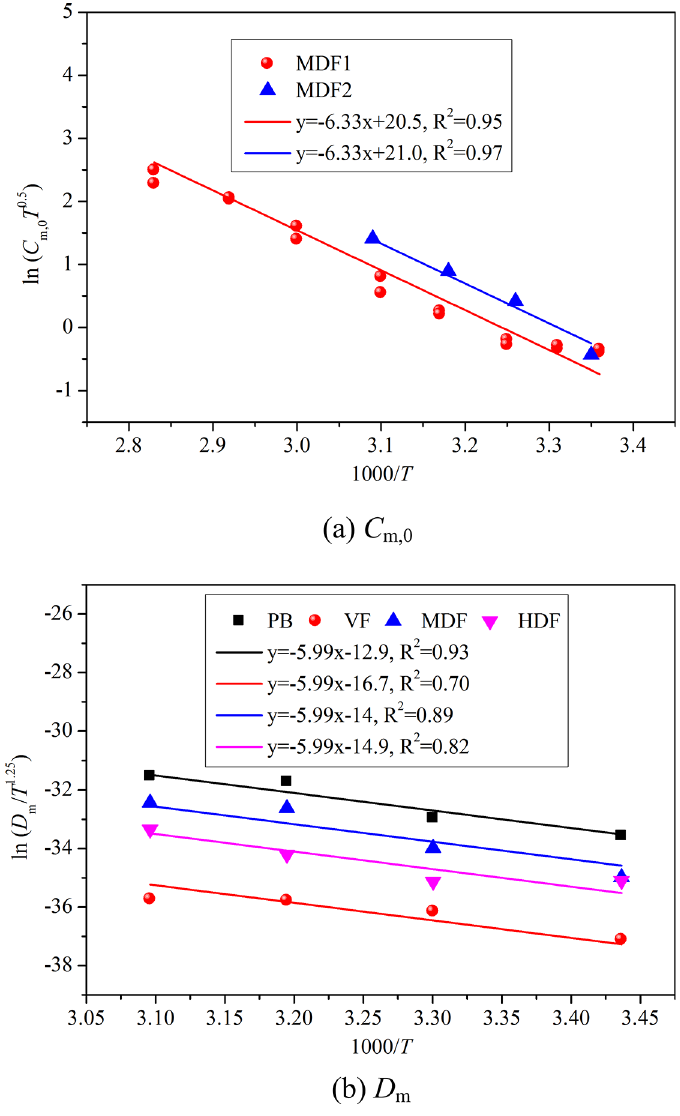
Fig 1. Linear curve fitting results by treating the experimental data with theoretical